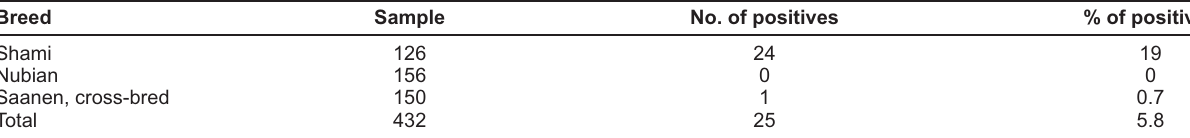
Table-3. CAEV Seropositivity in goat breeds detected by cELISA Nile states (Table-1).